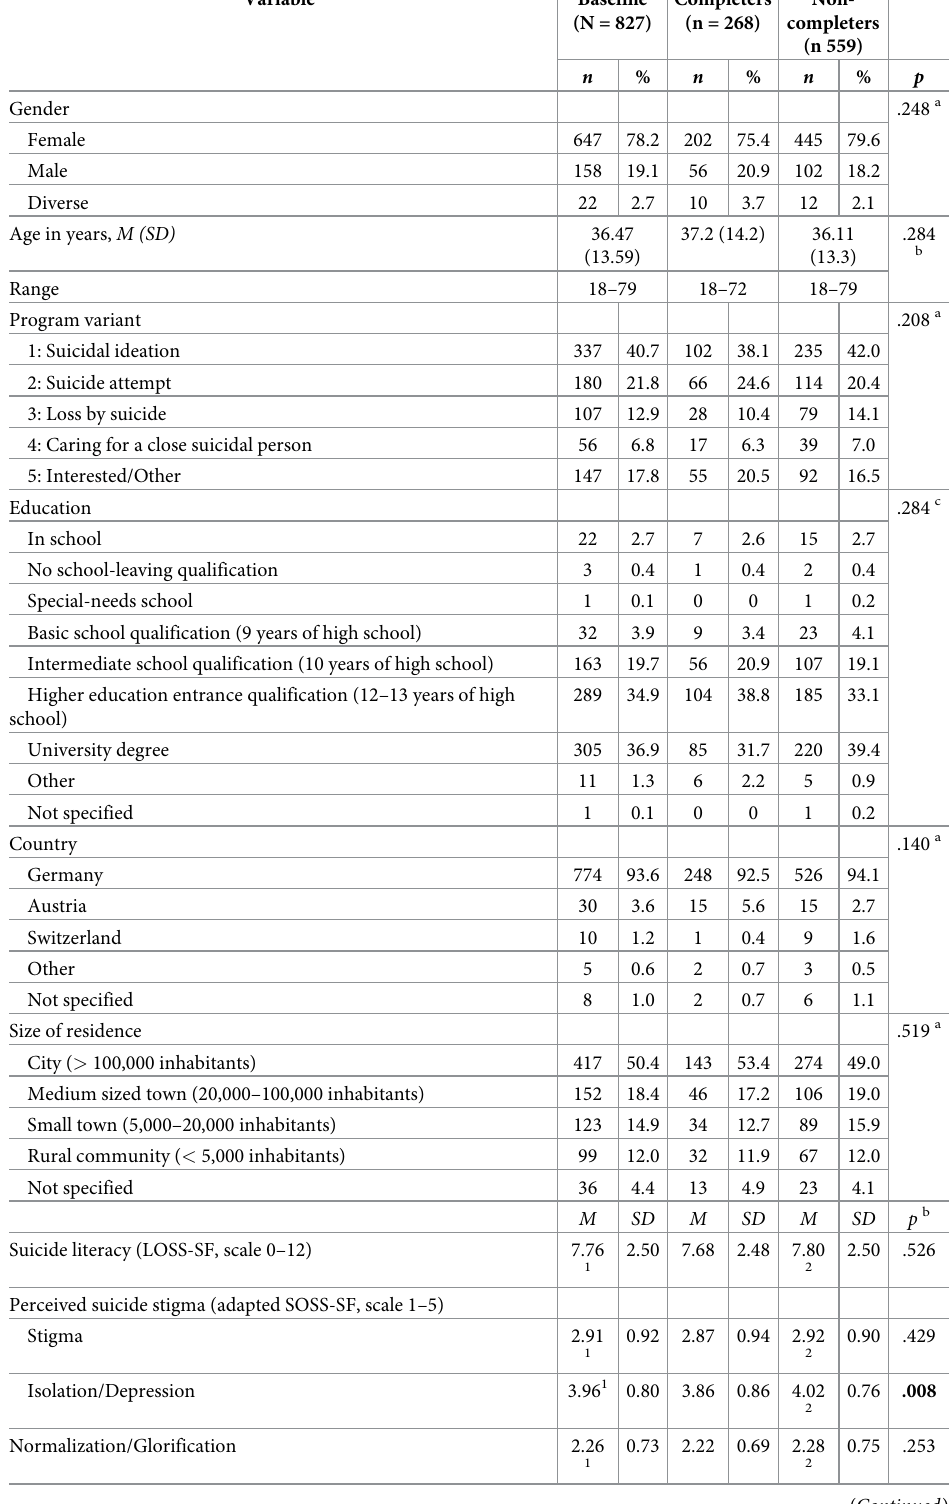
Table 1. Baseline data for total sample and compared between completers and